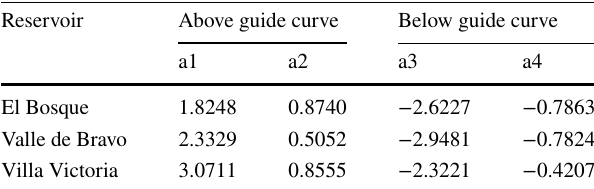
Table 10 The parameters of Eqs. 3 and 4 for optimal genetic algo‑ rithm GA3 policy Reservoir Above guide curve Below guide